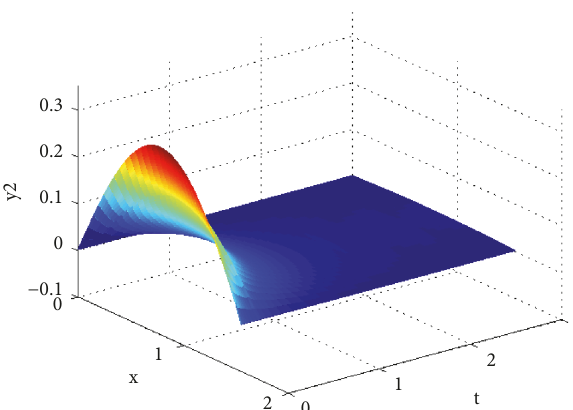
Figure 7: The closed-loop trajectory of 𝑦 2 (𝑥,𝑡) .